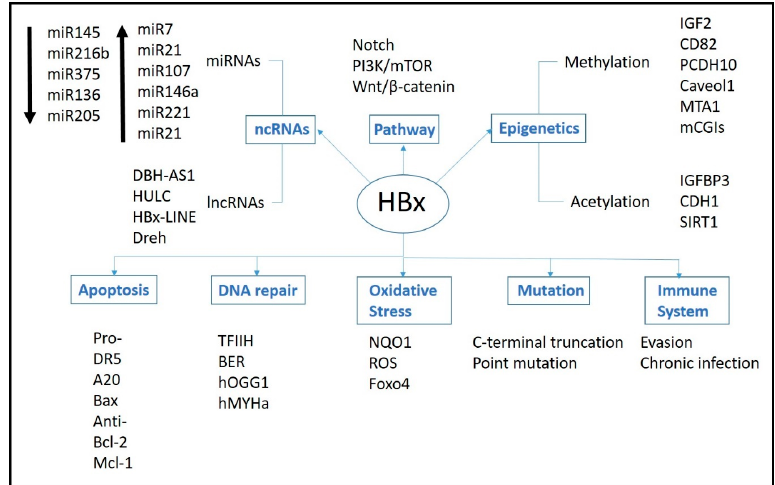
Figure 2. HBx and its mutifuntional roles in hepatocarcinogenesis. Each box represents processes that HBx may potentially play a role. The black arrows indicate up or downregulation of miRNAs.